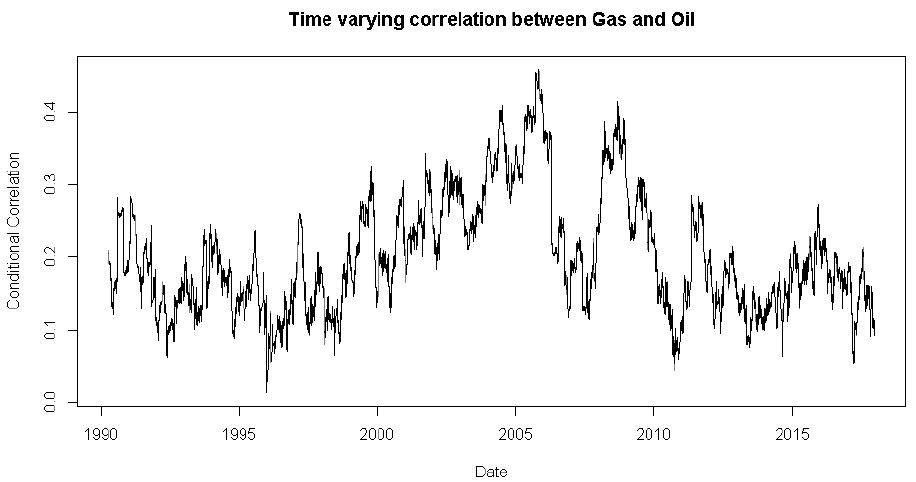
Figure 9. Time varying correlation between Gas and Oil.